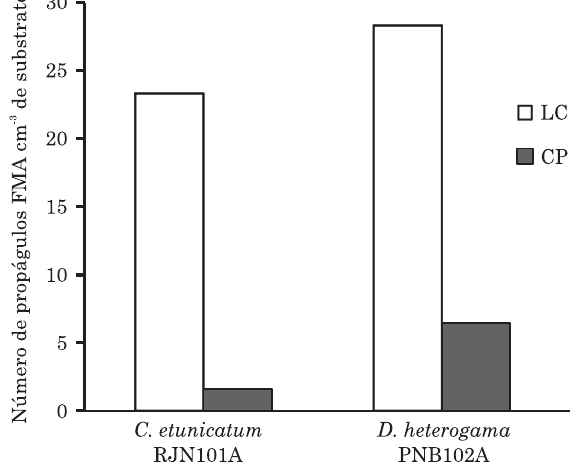
Figura 3. Número de propágulos infectivos de FMA em sistema on farm com substrato à base de lodo de celulose (LC) e casca de Pinus (CP), inoculados com Claroideoglomus etunicatum RJN101A e Dentiscutata heterogama